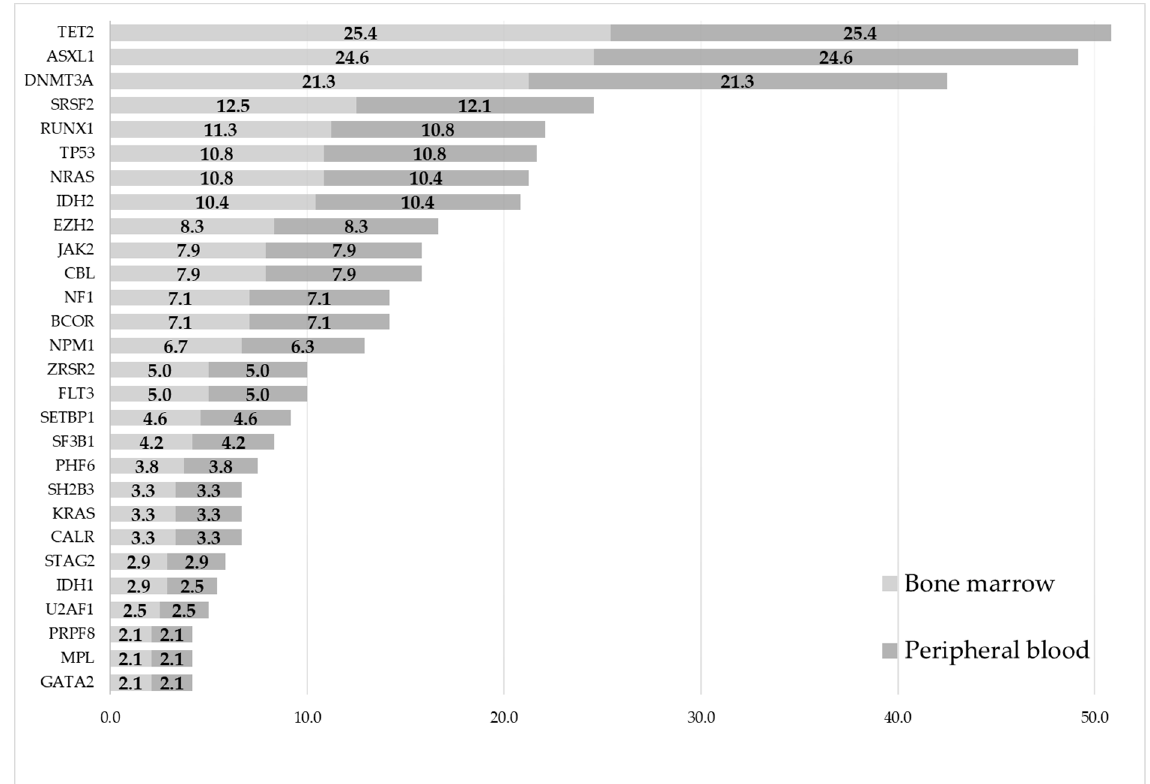
Figure 2. Occurrence of mutations by gene and by sample type for all samples (n = 150 patients, n = 191 sample pairs 1,2 , n = 1299 mutations detected 3,4 ). The X-axis represents the percentage of samples in which the respective mutation was found. ( 1 Includes 53 serial sample pairs from 30 patients. 2 Total sample pairs (n = 240), excluding sample pairs without mutations (n = 46) and excluding sample pairs in which only fusion genes (and no other mutations) were found (n = 3). 3 Mutations occurring in genes in <2% of the total cohort were not included in the graph and included the following genes for bone marrow vs. peripheral blood, respectively: MYD88 1.7% vs. 1.7%; ETV6 1.7% vs.